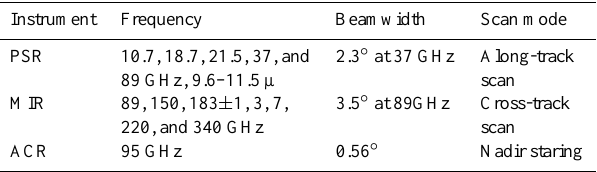
Table 1. Instrument specifications and operation modes during the Wakasa Bay cloud tomography